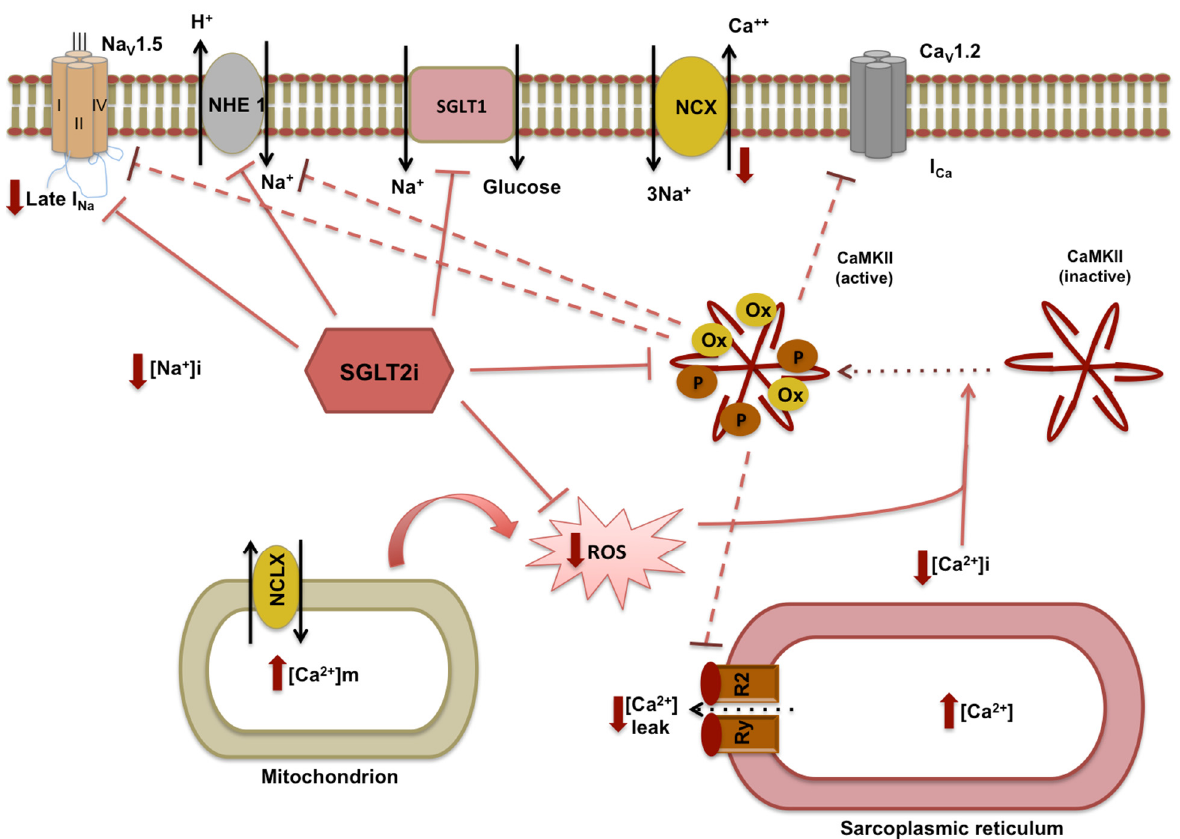
Figure 2. Downregulation of NHE-1, modulation of intramyocardial Ca 2+ and Na + fluxes by SGLT-2 inhibitors. The sodium hydrogen exchanger-1 (NHE-1) is upregulated in heart failure (HF) and diabetes. SGLT2i have a key role in the inhibition of NHE-1, sodium-glucose co-transporter 1 (SGLT1), and Na + /Ca 2+ exchanger (NCX), preserving the calcium and sodium homeostasis and attenuating the oxidative Ca 2+ /Calmodulin-dependent kinase II δ (CaMKII) activity. The modulation of Ca 2+ and Na + fluxes lead to a reduction in reactive oxygen species (ROS) and prevention of the cytosolic increase in calcium because of the mitochondrial and sarcoplasmic release caused by mitochondrial Na + /Ca 2+ exchanger (NCLX) and ryanodine receptor 2 S(RyR2).